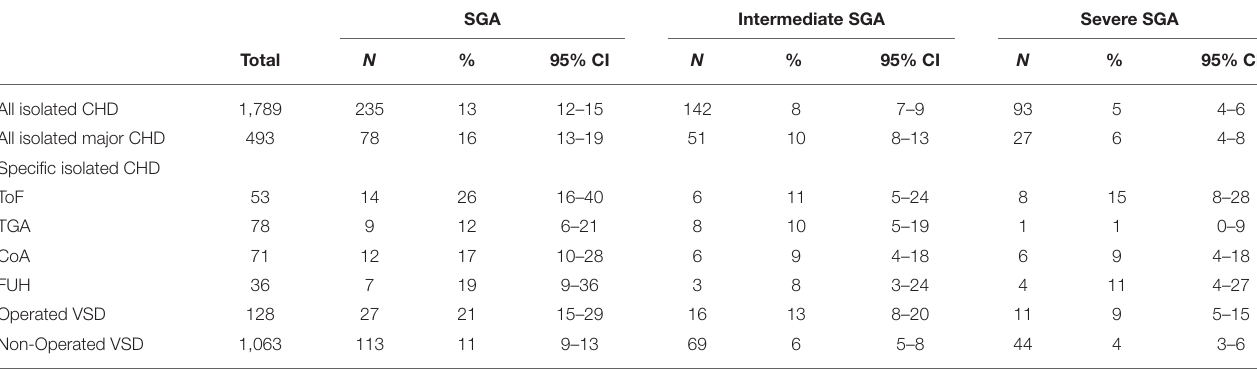
TABLE 2 | Proportions of SGA ( < 10th percentile), intermediate SGA ( ≥ 3rd percentile < 10th percentile), and severe SGA ( < 3rd percentile) for all isolated CHD, major isolated CHD, and isolated specific CHD. SGA